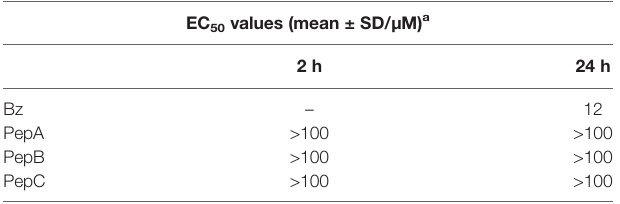
TABLE 5 | The biological effect of the peptides and benznidazole (EC 50 values at µM) against bloodstream trypomastigotes of Trypanosoma cruzi (Y strain) after 2 and 24 h of incubation at